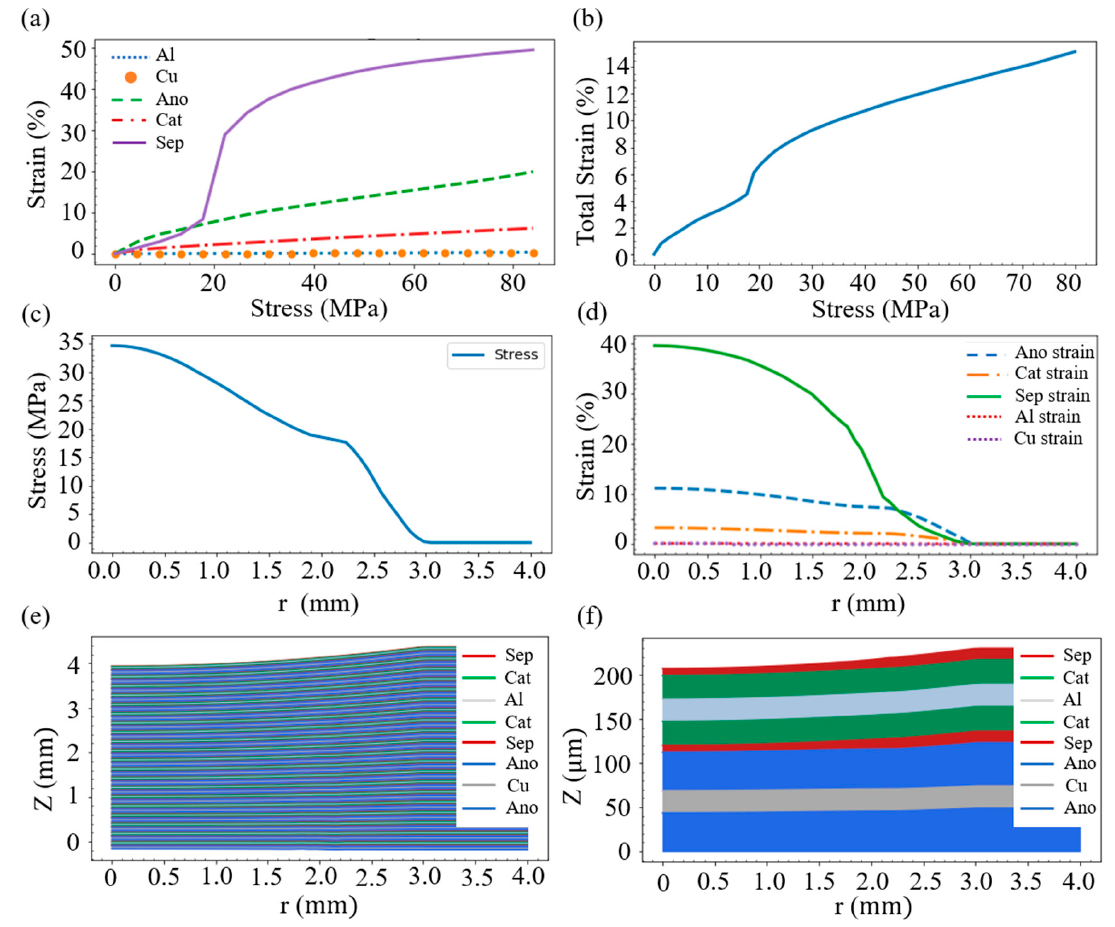
Figure 2. ( a ) Compressive stress–strain relation of the main materials inside the battery. The materials of the negative electrode include lithium carbon compound and electrolyte, while the positive electrode contains nickel manganese cobalt (NMC) and electrolyte. The separator is a mixture of high molecular polymer (PVDF) and electrolyte. ( b ) Stress–strain relation of the whole battery. ( c ) Stress distribution at different locations. ( d ) Strain of each layer at different positions. ( e ) Deformation of each layer. ( f ) Deformation of the first unit of layers.